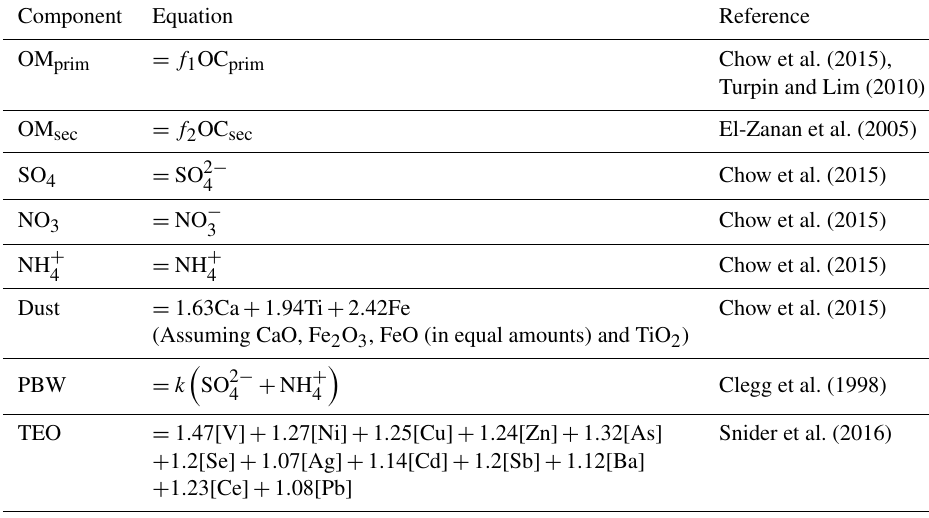
Table 1. Equations used to estimate the main components of PM 2 . 5